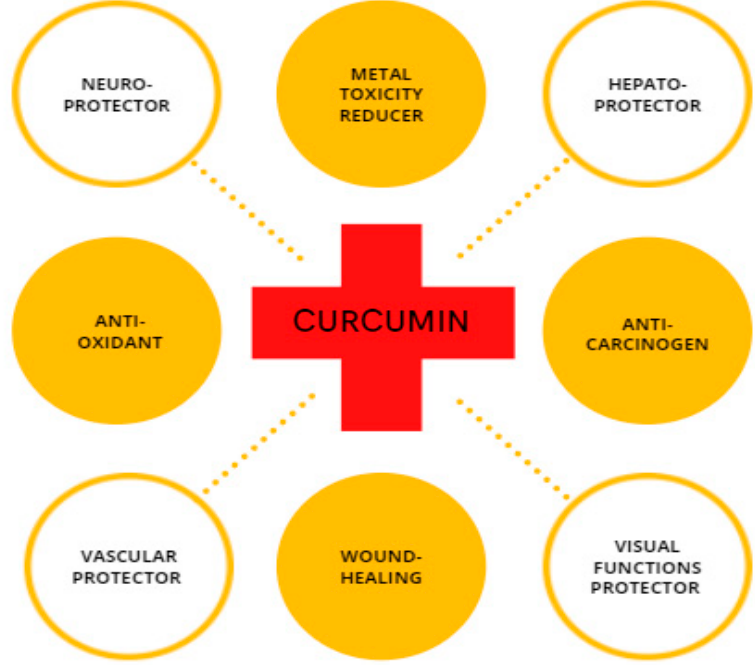
Figure 2. Schematic illustration of CUR with its biological